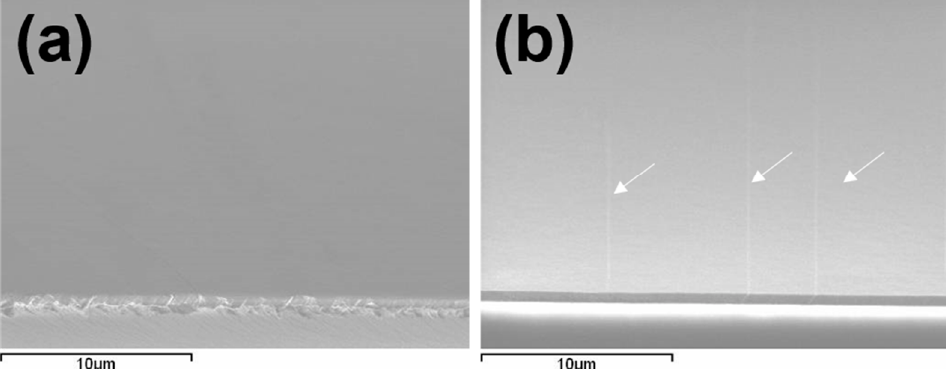
Figure 3. ( a ) Angled-view SEM image showing crack-free surface after in situ annealing at 1000 °C for 30 s and ( b ) angled-view SEM image showing the presence of extended cracks after ex situ RTA at 1000 °C for 30 s where cracks are indicated as white arrows.